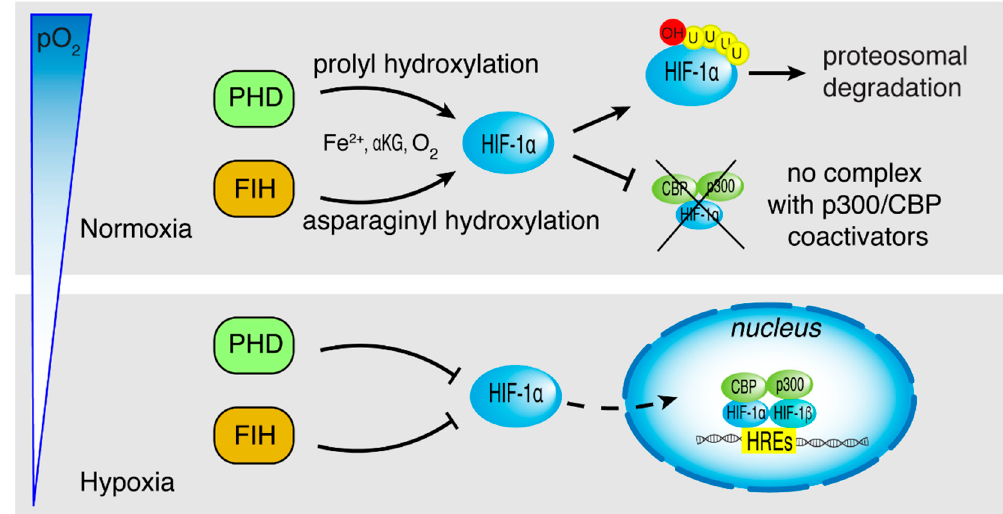
Figure 2. Oxygen-dependent regulation of HIF-1 α . Under normoxia (upper panel), HIF-1 α proline hydroxylation promotes proteasomal degradation, while HIF-1 α asparagine hydroxylation blocks CBP/p300 binding, thus impairing HIF-1 α function. Both prolyl (PHD) and asparaginyl (FIH) hydroxylases require Fe(II), O 2 , and α -ketoglutarate ( α KG). Under hypoxia (lower panel), HIF-1 α is not hydroxylated, and its nuclear translocation allows the dimerization with HIF-1 β , the combining with the coactivators CBP/p300, and thereby, the binding to hypoxia response elements (HREs), increasing the transcription of target genes.